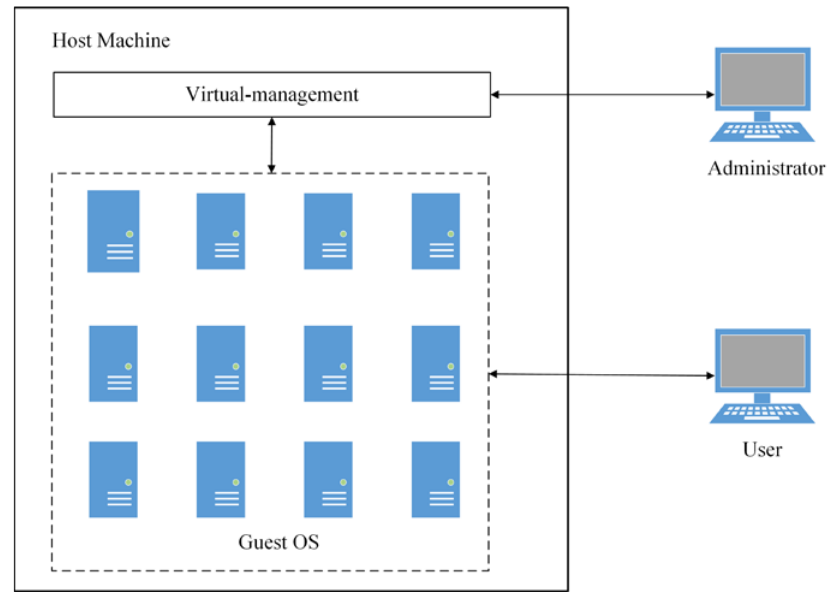
Figure 2. NVBLab